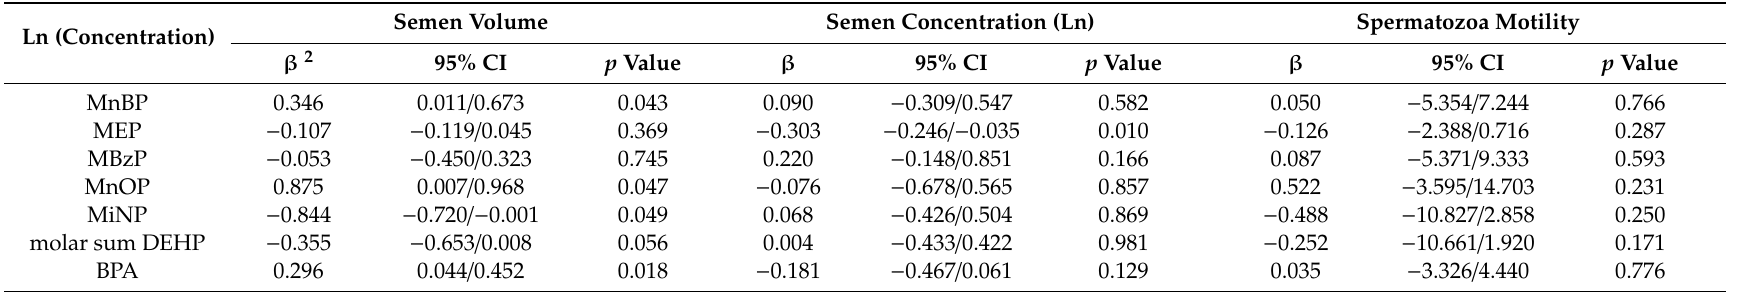
Table 4. Estimated coe ffi cients (95% confidence intervals) from separate multivariate adjusted 1 linear regression models of each semen parameters on the natural logarithm of each metabolite